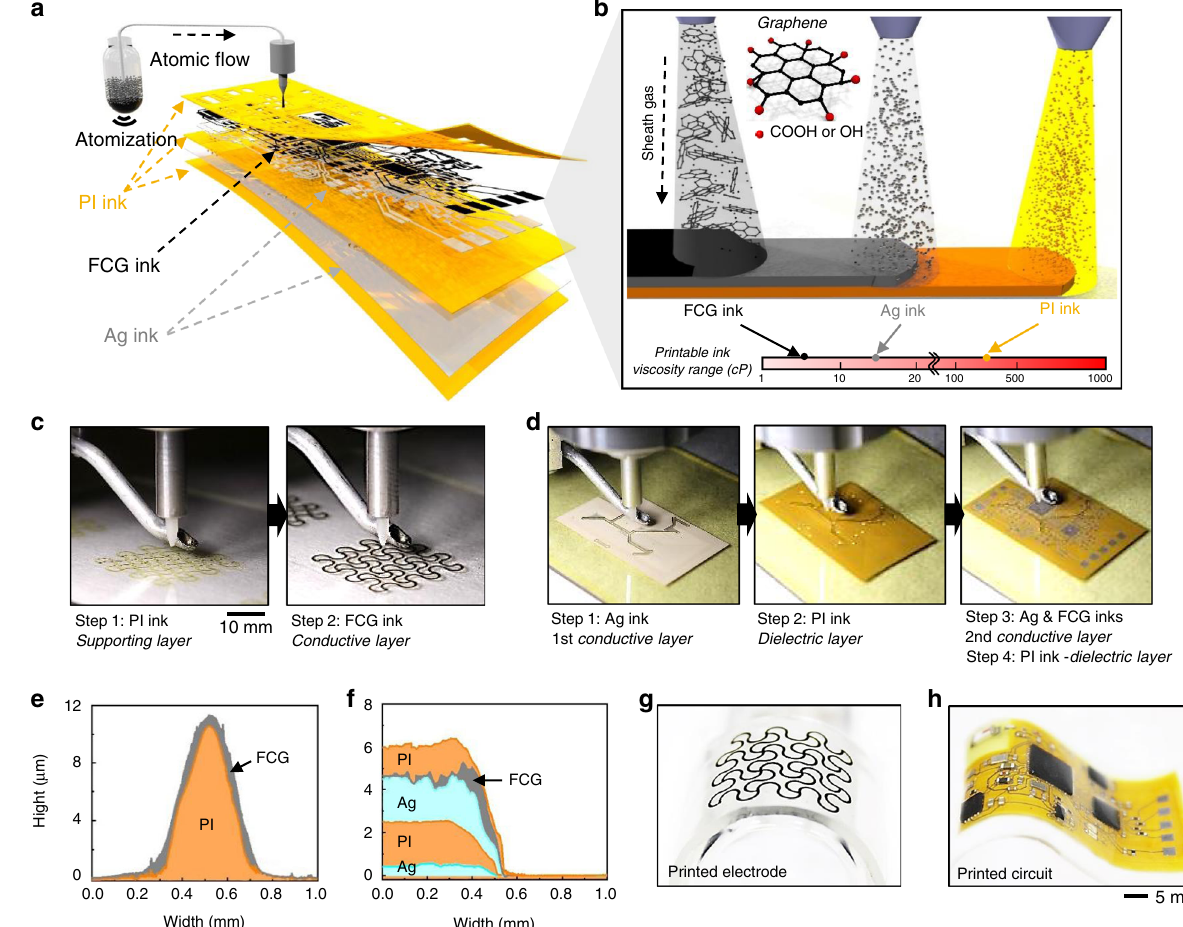
Fig. 1 Design, architecture, and nanomanufacturing of a p-NHE. a , b Schematic illustrations of printing of aerosol nanoparticles from PI, Ag, and graphene inks to construct a multilayered structure. The atomized droplets in a N 2 gas stream are directed to the print head to draw desired patterns on a substrate ( a ). The aerosol stream is controlled and delivered by a sheath gas to the substrate; three types of inks with different viscosity values are sequentially printed in this work ( b ). Small inset shows a chemical structure of graphene which is partially oxidized with carboxylic and hydroxyl groups. c Sequential photos of printing of PI and graphene ink to fabricate a stretchable nanomembrane electrode. In Step 1, PI ink is printed on a PMMA/glass substrate as a supporting layer. In Step 2, graphene ink is printed on top of the PI as a conductive layer for an electrode. d Still images showing a printing process of a multilayered biopotential recording circuit. In Step 1, Ag ink is deposited on a PI/PMMA/glass substrate as a circuit ground plane. In Step 2, PI ink is deposited as a dielectric layer except where the VIAs are located. In Step 3, Ag and FCG inks are printed as a metal interconnect layer that is connected to the ground plane. In Step 4, additional PI ink is printed to completely enclose the entire circuit except contact pads to integrate functional chip components. e , f Measured cross-sectional pro fi les of a printed stretchable electrode ( e ) and a printed multilayered circuit ( f ). g , h Close-up photos of the printed electrode ( g ) and circuit ( h ) on elastomeric membranes in e and f